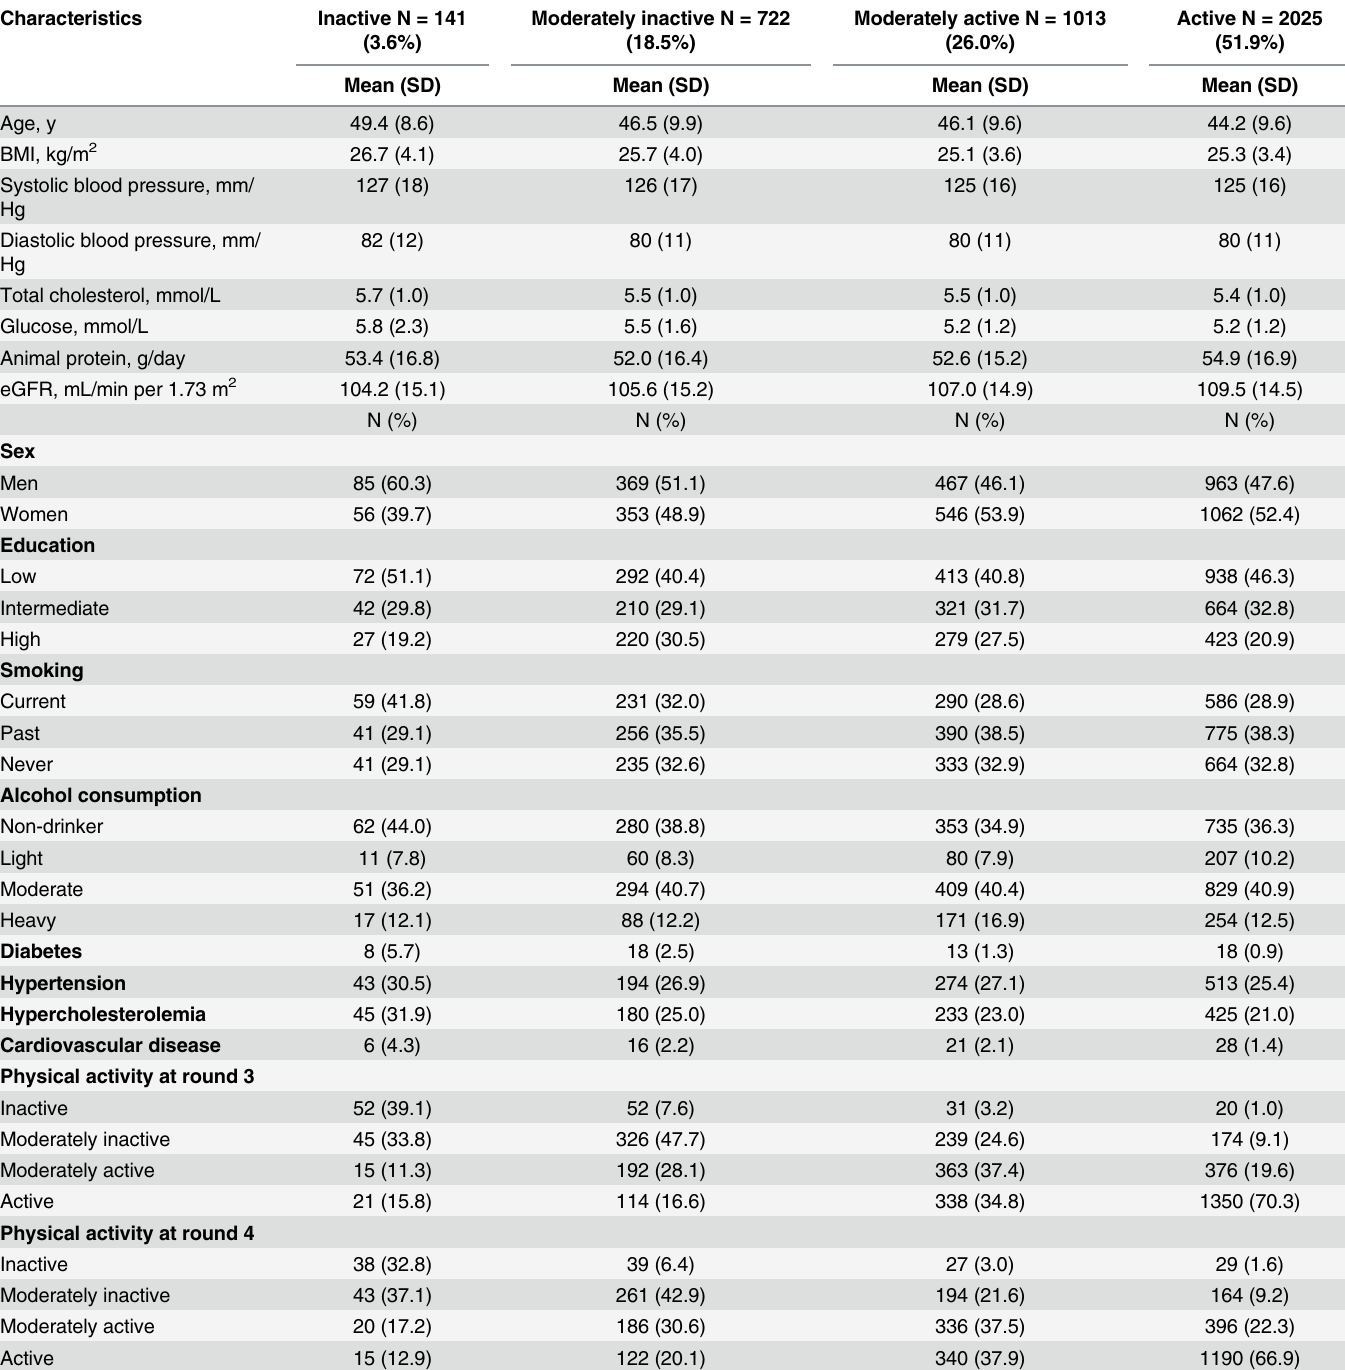
Table 1. Characteristics of study population according to physical activity at round